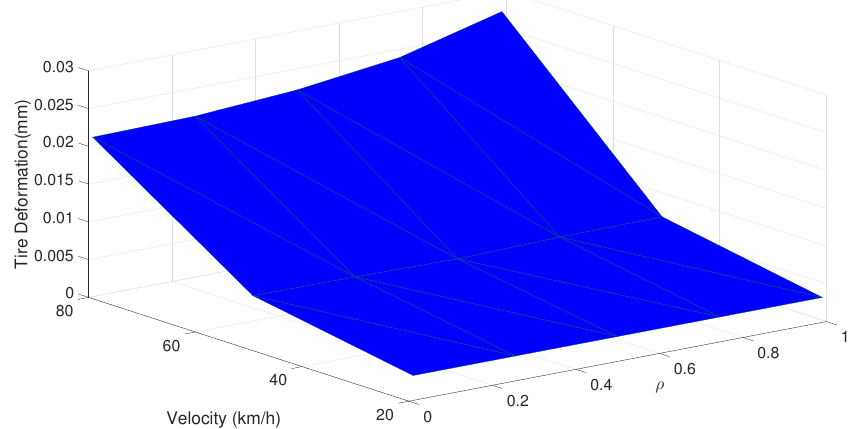
Figure 7. Tire deformation map for 10 cm bump.